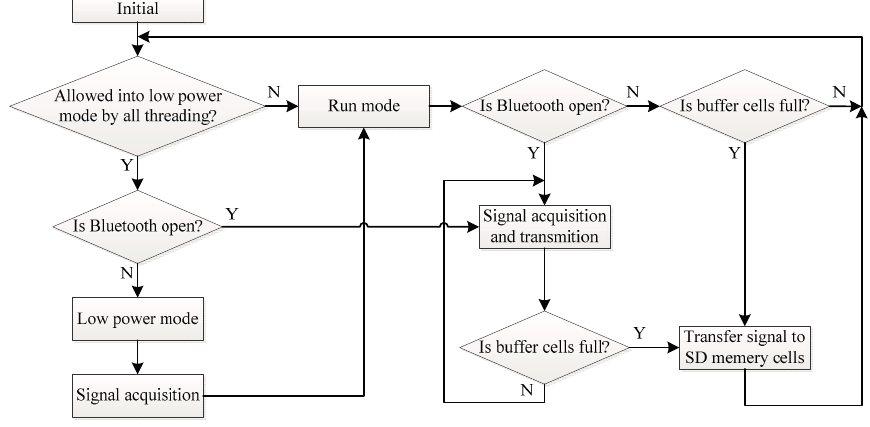
Figure 4. Flow diagram of the scheduling of a micro control unit